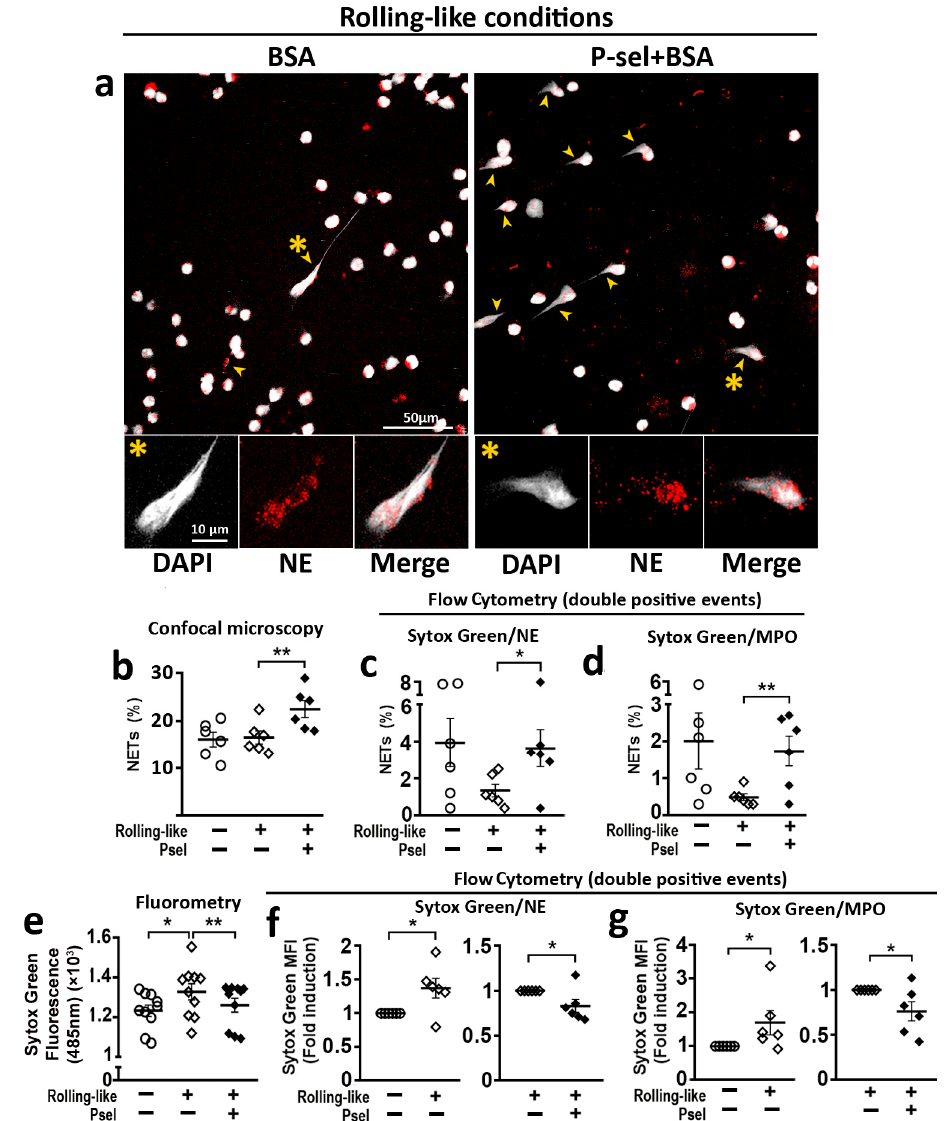
Figure 4. Interaction of HD neutrophils with P-selectin regulates NET generation. Peripheral neu- trophils isolated from healthy donors were incubated in rolling-like conditions. ( a ) Representative confocal microphotographs taken with 63 × and 63 × plus 5 × digital zoom of DAPI/NE staining neutrophils in rolling-like experimental conditions on BSA or BSA+P-selectin. Scale bar = 10–50 µ m. Yellow arrowheads indicate NETs. Yellow asterisks indicate NETosing cells amplified below the image. ( b ) Percentage of NETs quantified by confocal microscopy. ( c , d ) Percentage of NETosing cells in ( c ) Sytox Green/NE-APC and ( d ) Sytox Green/MPO-PE double positive events, respectively. ( e ) Extracellular Sytox Green MFI analyzed by fluorometry at 485 nm. ( f , g ) Sytox Green MFI fold induction in ( f ) Sytox Green/NE-APC and ( g ) Sytox Green/MPO-PE double positive events, respec- tively. Data are presented as MFI fold induction or percentage ± SEM. Statistical analysis was per- formed using paired Student’s t -test and Wilcoxon test. * p ≤ 0.05; ** p ≤ 0.01; n = 6–12. NETs: Neu- trophil extracellular traps. HD: healthy donors. NE: Neutrophil elastase. MPO: Myeloperoxidase.